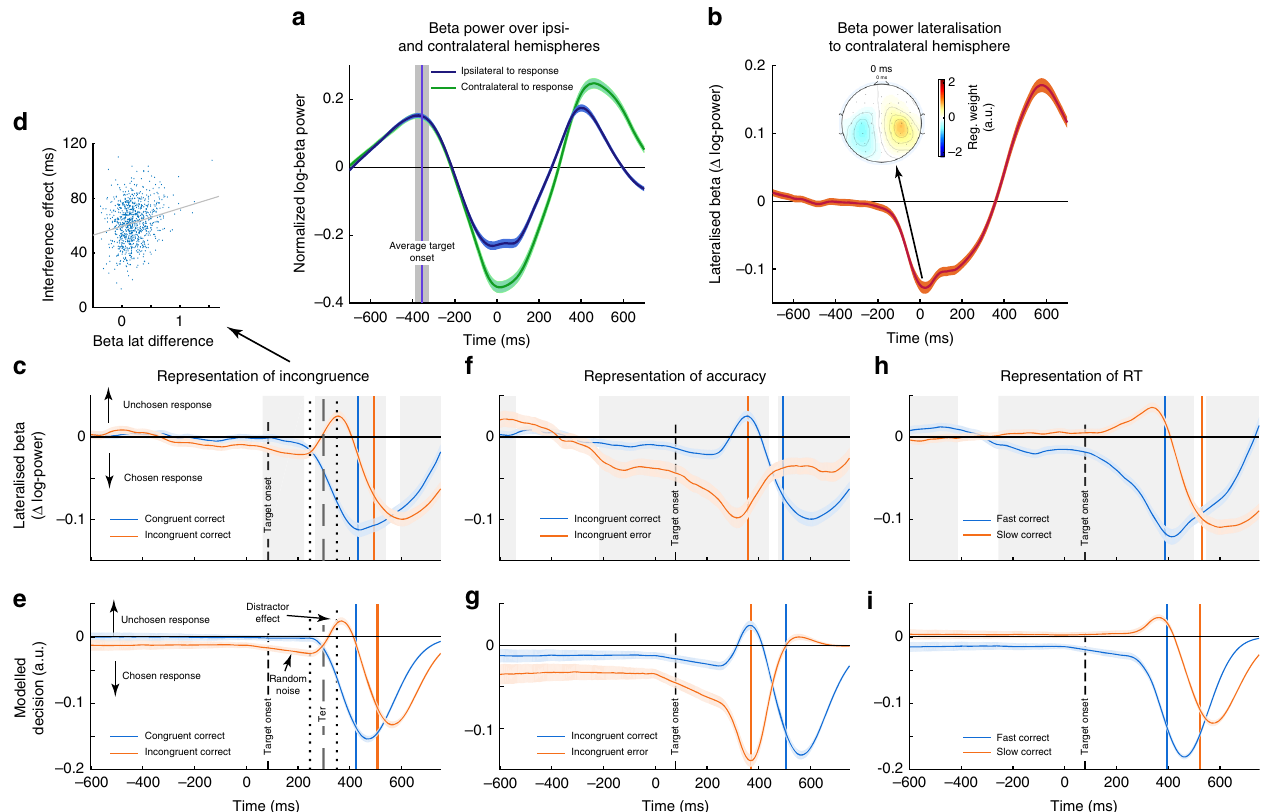
Fig. 5 Stimulus related beta power and simulated decision variable. a The BPL is composed of the activity-difference recorded over contralateral (green) and ipsilateral motor cortices (blue). A statistically signi fi cant lateralisation towards the contralateral motor cortex is seen around 200 ms prior to response execution ( b ). The inset shows a regression weight map of the scalp topography of beta power when regressed against the side of motor execution according to Eq. 6 (see Methods and Supplementary Figure 4 for details). c , e Comparison of distractor effects on BPL ( c ) and modelled decision signal in the DDM during stimulus processing ( e ). Distractor effects were seen at similar times on incongruent (red) compared to congruent trials (blue): distractors pushed BPL and decision variable away from the correct response. d Across participants, the degree of distractor representation in BPL (mean between 340 – 420 ms) positively correlated ( r = .20, p < 10 − 16 ) with the interference effect on RT. Notably, many features of the time-course and dynamics of BPL were closely predicted by the diffusion variable of the DDM. Non-decision time ( T er ) re fl ects stimulus processing without in fl uence of stimulus information and the onset of BPL matches T er plus its variance (dots surrounding vertical dashed line in c and e ). The similarities extend to pre- stimulus effects. Here, both signals are lateralised towards the chosen response which is caused by single-trial start-point variance in the DDM affecting accuracy and RT. Strong pre-stimulus bias leads to errors ( g ) but also quick (based on median splitting) responses ( i ) in the model. The same patterns are evident in the BPL plots ( c , f , h ), suggesting that BPL in fl uences speed and accuracy of upcoming responses. In the DDM, this is caused by the causal relationship between start-point variance and accuracy as well as RT. The striking similarity between diffusion signal and BPL hints at similar relationships for the neural data. Note that the pre-stimulus bias is absent when trials are plotted without mapping to the executed response. Shades represent 99.9% CI, the vertical blue and orange lines in c – i re fl ect mean RT per condition. Grey backgrounds in ( c , f , h ) indicate signi fi cant time-points after